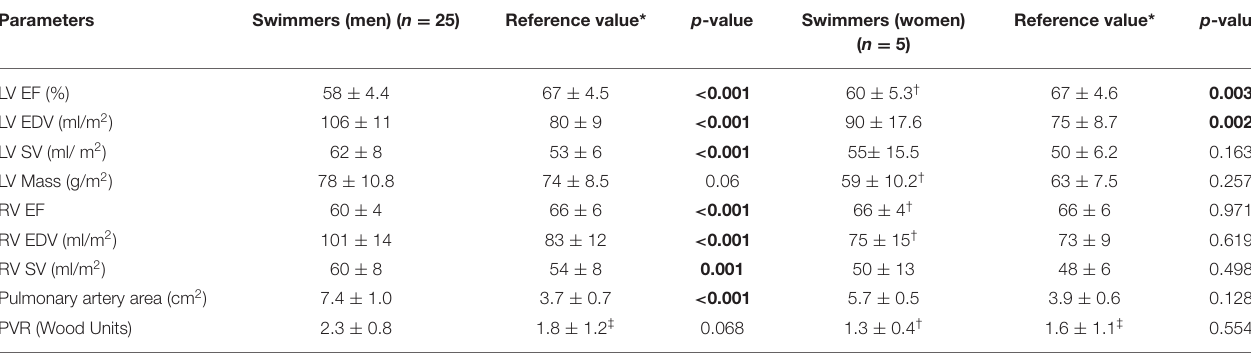
TABLE 2 | Cardiac magnetic resonance parameters in endurance swimmers according to sex.